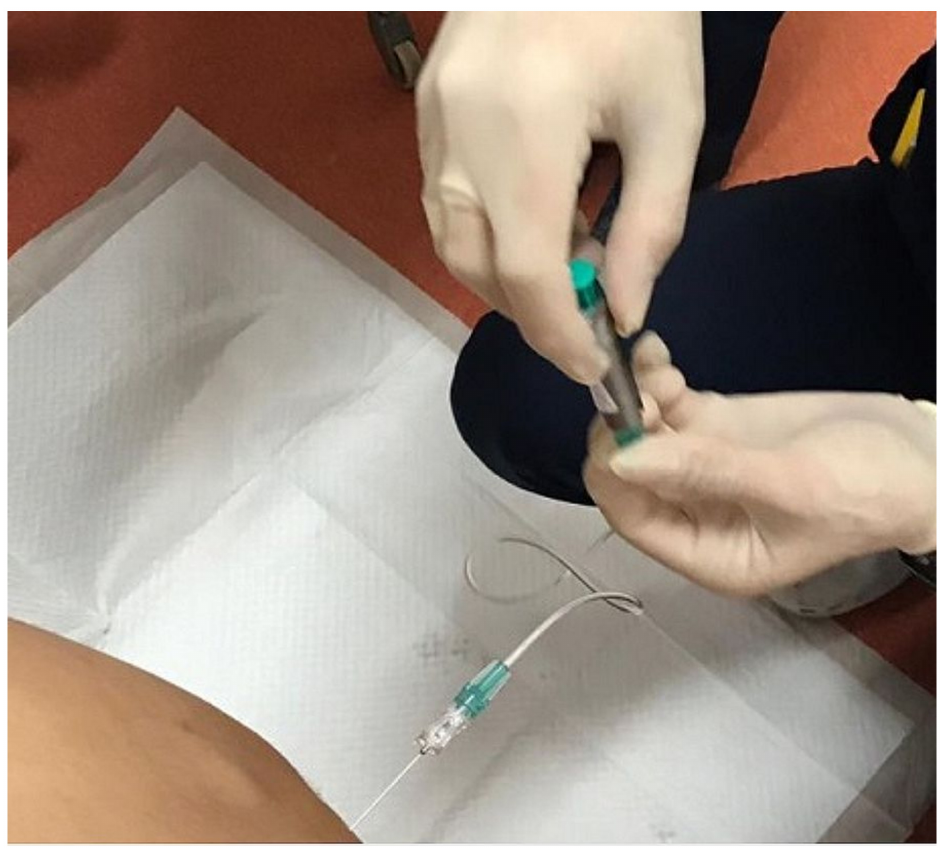
Figure 2. Application of the radioisotope via LP needle with additional